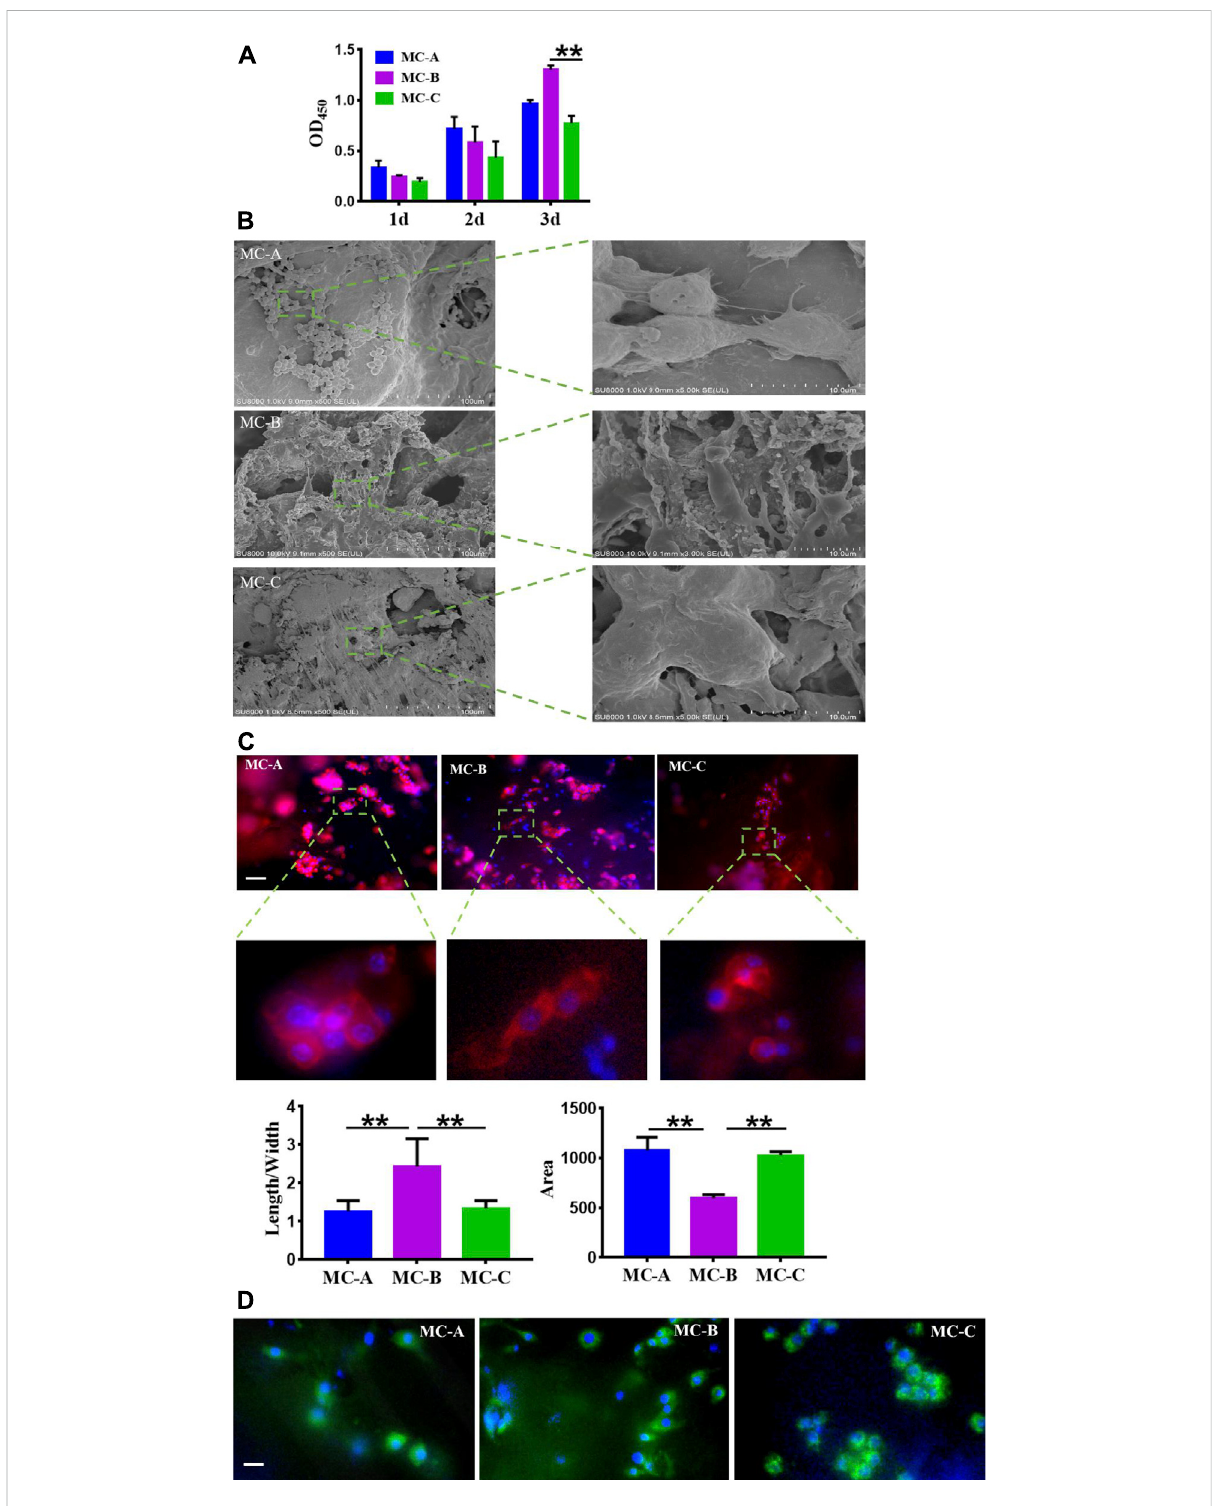
FIGURE 4 Effects of mineralized collagen with different microporous structures on macrophages morphology. (A) CCK-8 cell proliferation experimentation of RAW 264.7 cells after cultured 1 d, 2 d, and 3 days in vitro ; (B) Population and individual morphology of macrophages grown on different mineralized collagen (scale bar:100 μ m); (C) Detection of the cytoskeleton morphology of macrophages cultured for 3 days by rhodamine labeledphalloidinstaining(scalebar:50 μ m); (D) Immuno fl uorescencedetectionoffocaladhesionmorphologyofmacrophagesafter3 daysof co-culture (scale bar: 50 μ